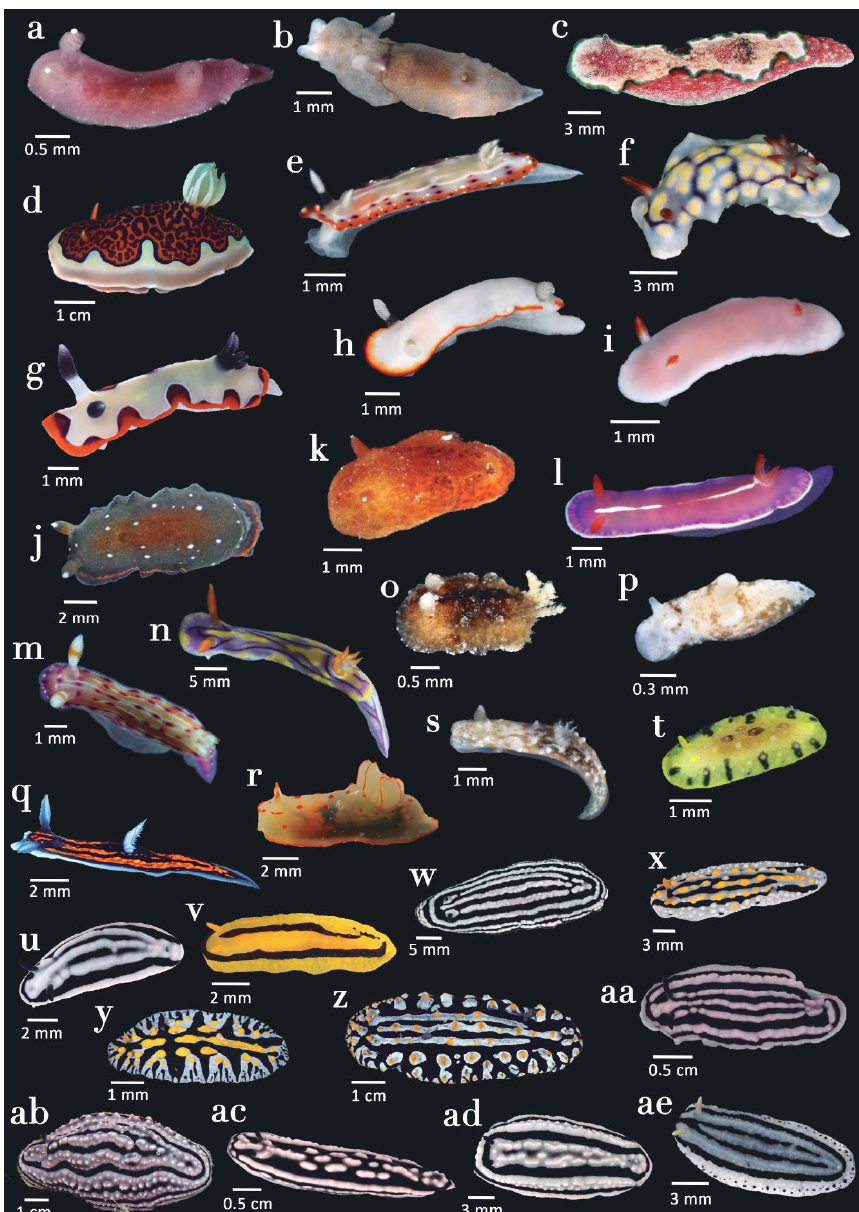
Figure 6. Nudibranchia, Doridina: ( a ) Hallaxa indecora (MCZ:Mala:393835); ( b ) Hallaxa fuscescens